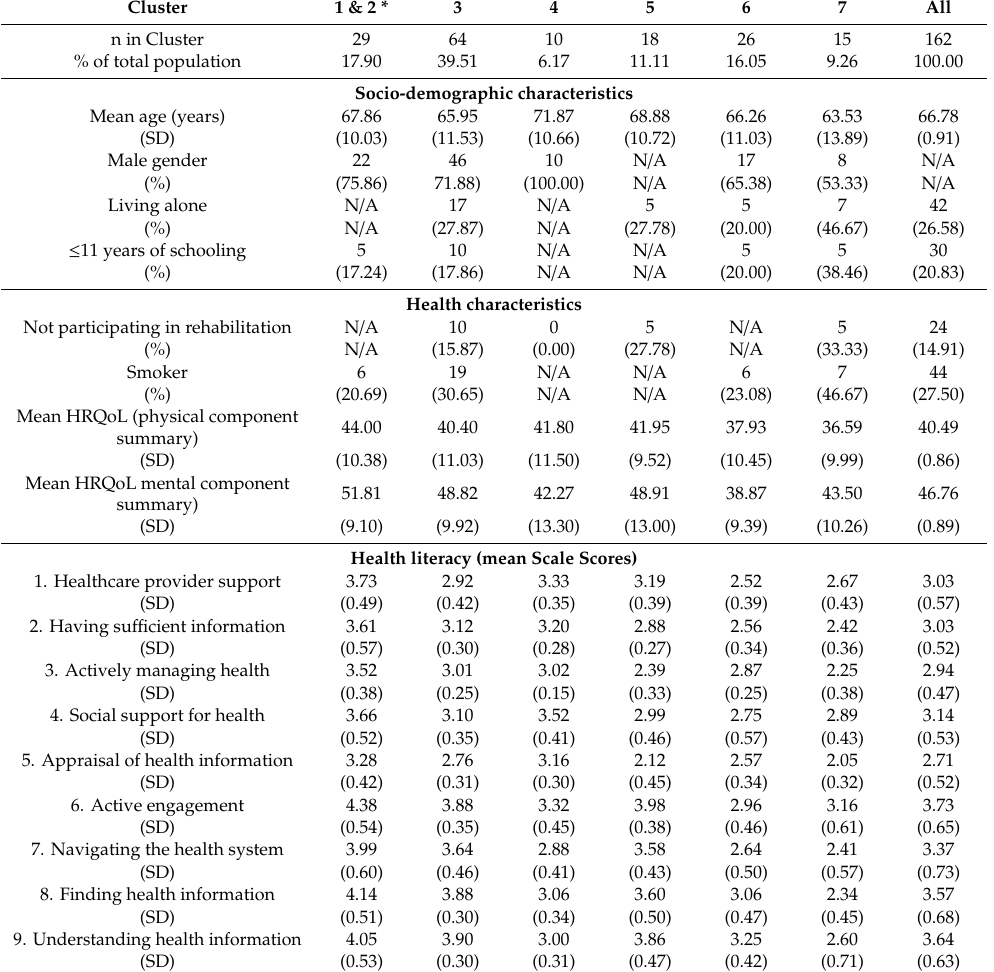
Table 2. Socio-demographic, health, and health literacy characteristics by cluster ( n = 162) in the Heart Skills Study survey